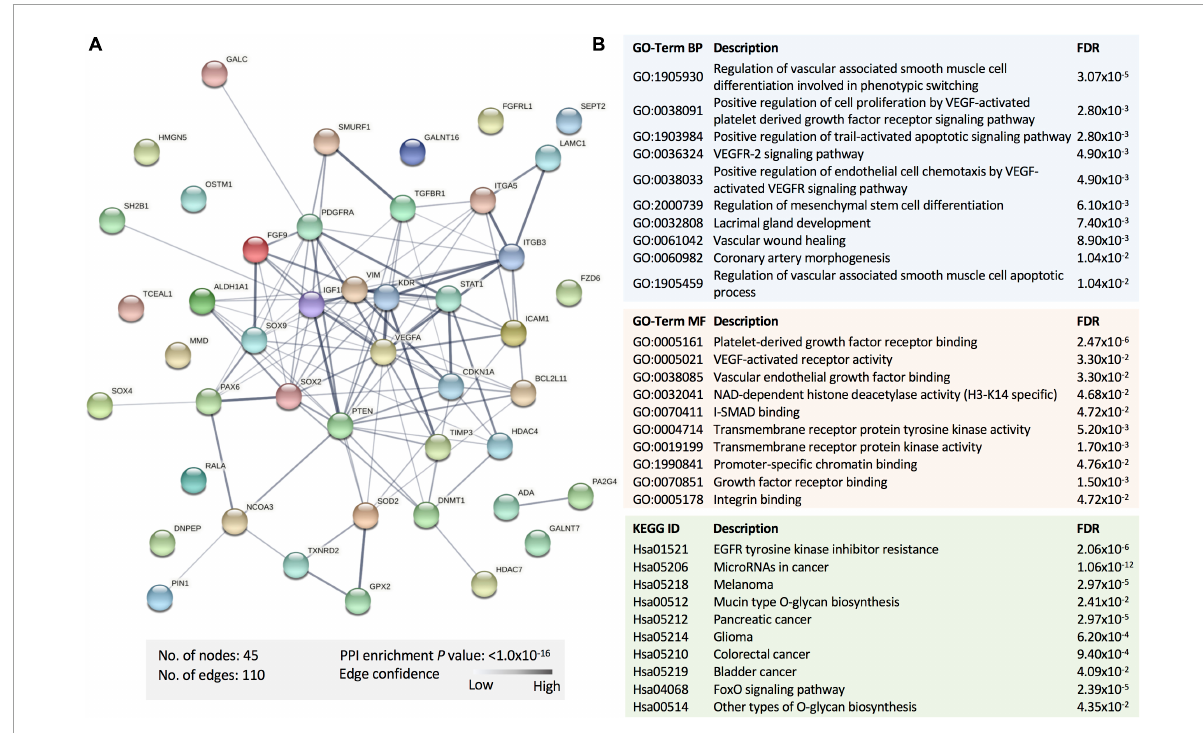
FIGURE4 Functional enrichment analysis of the proteins encoded by the gene targets of dysregulated miRNAs in SWDM versus SWoDM patients. (A) The protein–protein interaction (PPI) network generated for the 47 gene targets of the identified miRNA panel is shown. Network nodes represent proteins, while edges depict protein–protein associations. The key network statistics are also presented. (B) The top functional enrichment annotations from Gene Ontology (GO), biological process (BP)/molecular function (MF), and Kyoto Encyclopedia of Genes and Genomes (KEGG) pathways are